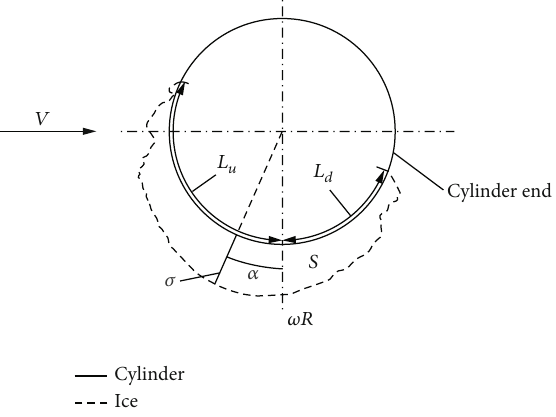
Figure 10: Typical characteristics of icing shape on the